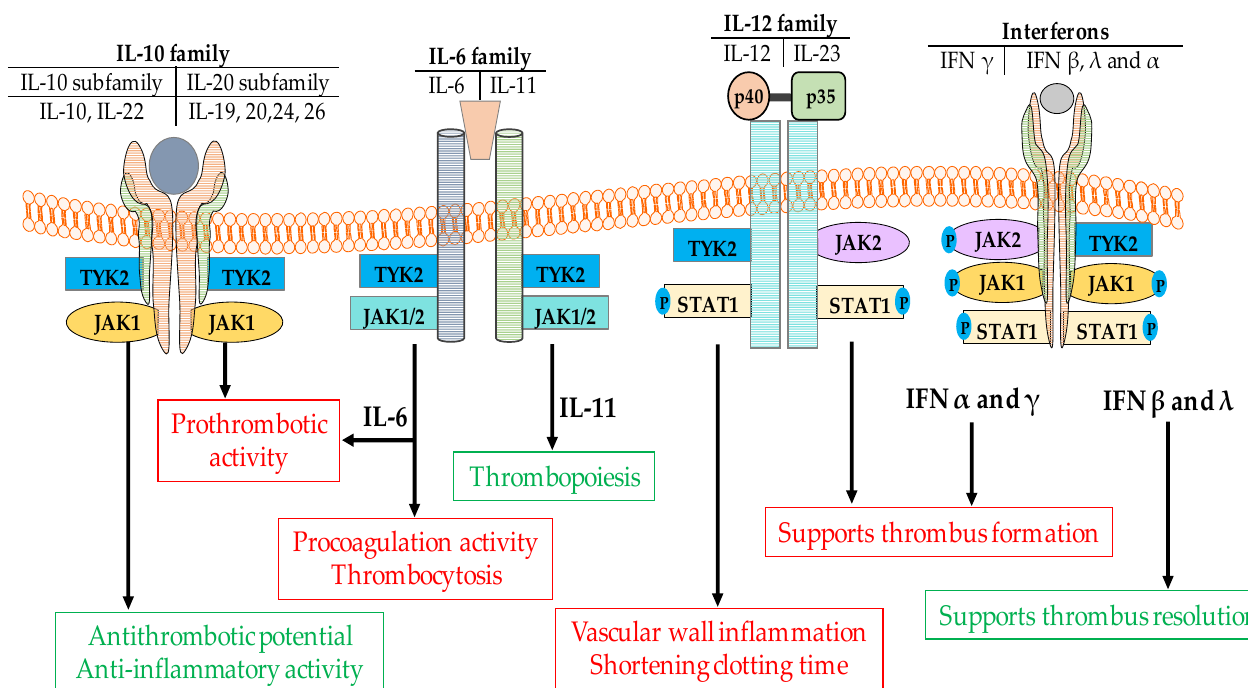
Figure 2. Diverse role of cytokines in thrombus formation. Cytokines belonging to the IL-10 family exert different functions; the three anti-inflammatory cytokines (IL-10, IL-19, IL-22) exert anti-thrombotic potential whilst other cytokines in family (namely IL-20, IL-24, IL-26) show strong proinflammatory activity. These pro and anti-inflammatory activities are transmitted via different JAK pairings; JAK1/TYK2 and JAK1/JAK2 for pro and anti-thrombotic activity respectively. Targeted inhibition of a given JAK can thus either block or augment the prothrombotic activity. Proinflammatory cytokines from the IL6 and IL-12 families also signal through JAK1, JAK2 and TYK2, thus administration of Jakinibs may block pro-inflammatory (pro-thrombotic) signals downstream of these cytokines. The more diverse type of signaling is observed in IFN family. IFN- α and IFN- γ exert strong proinflammatory potential, while IFN- β and IFN- λ show anti-inflammatory activity. Among all four types of INFs only IFN- γ is signaling via JAK1/JAK2 pair The remaining ones utilize JAK1/TYK2 pair. This shows that type of signaling (pro or anti-inflammatory) is unrelated to JAK composition, but the clinical effect depends on the extent to which the pro- and anti-inflammatory pathways are blocked by any particular Jakinib. Table 1. Role of selected cytokines in thrombus formation.